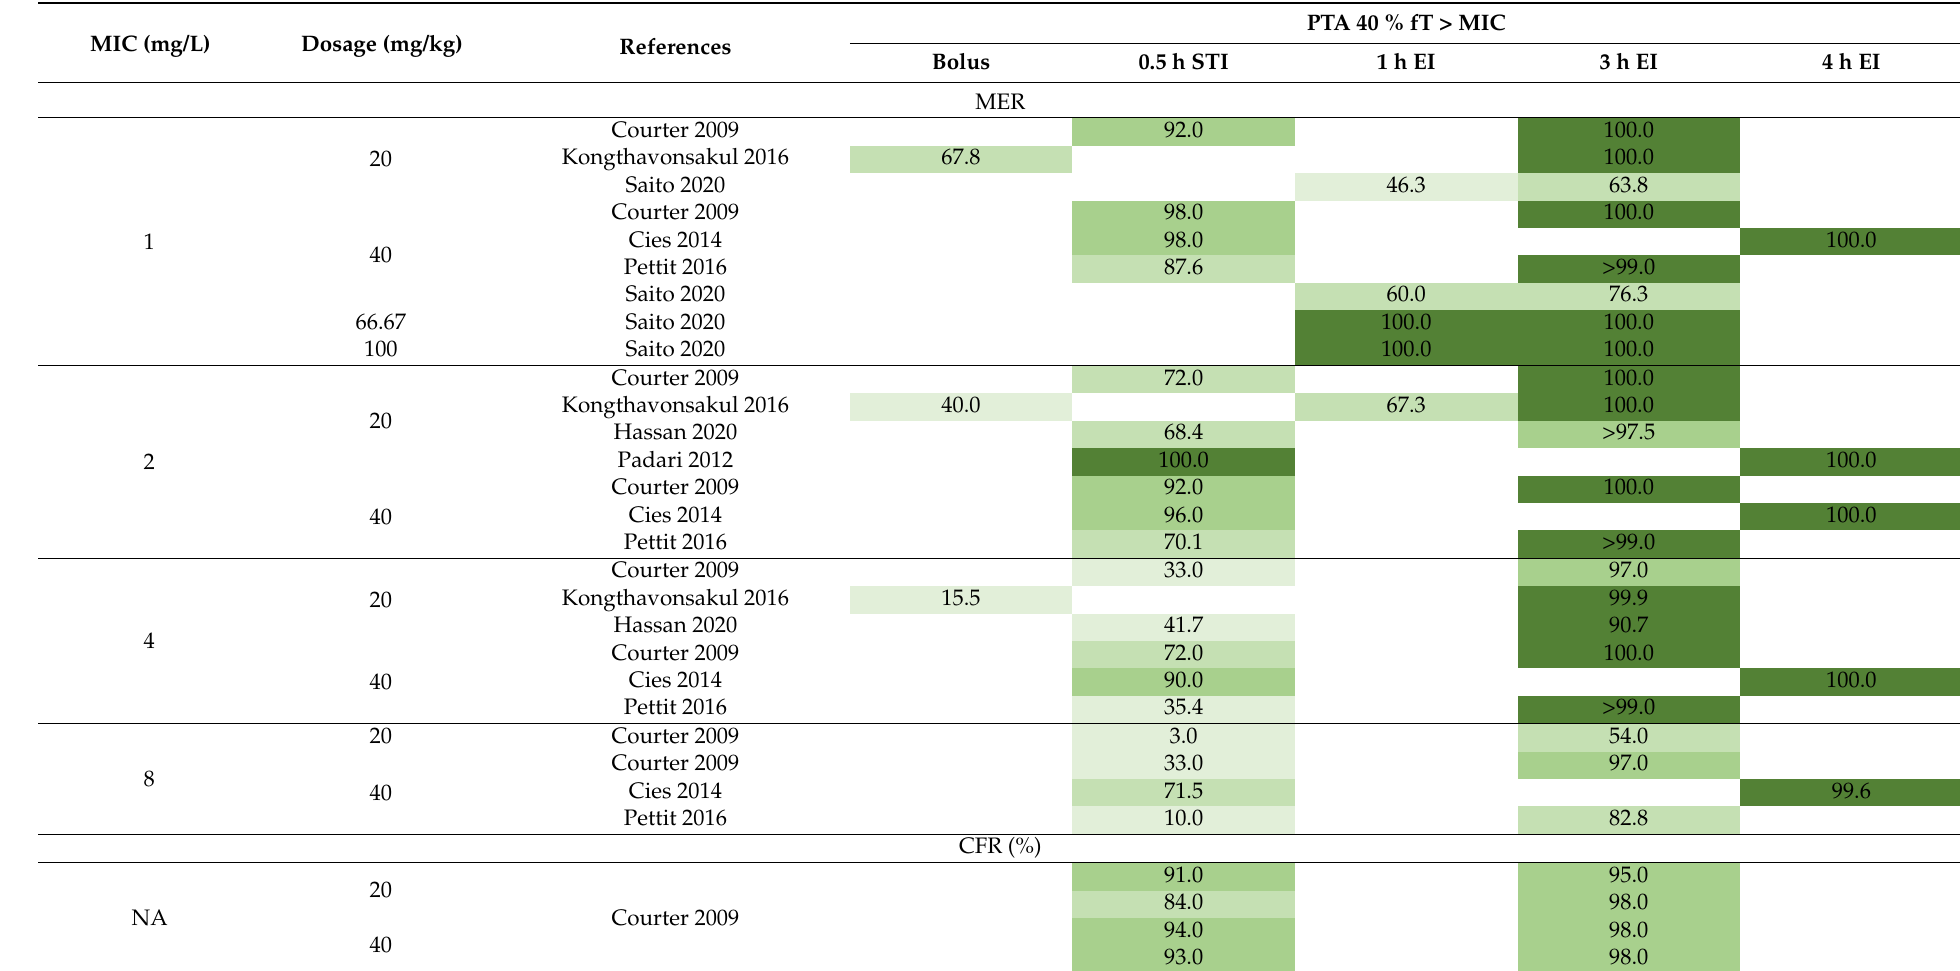
Table 3. PTA and CFR under different optimization schemes of